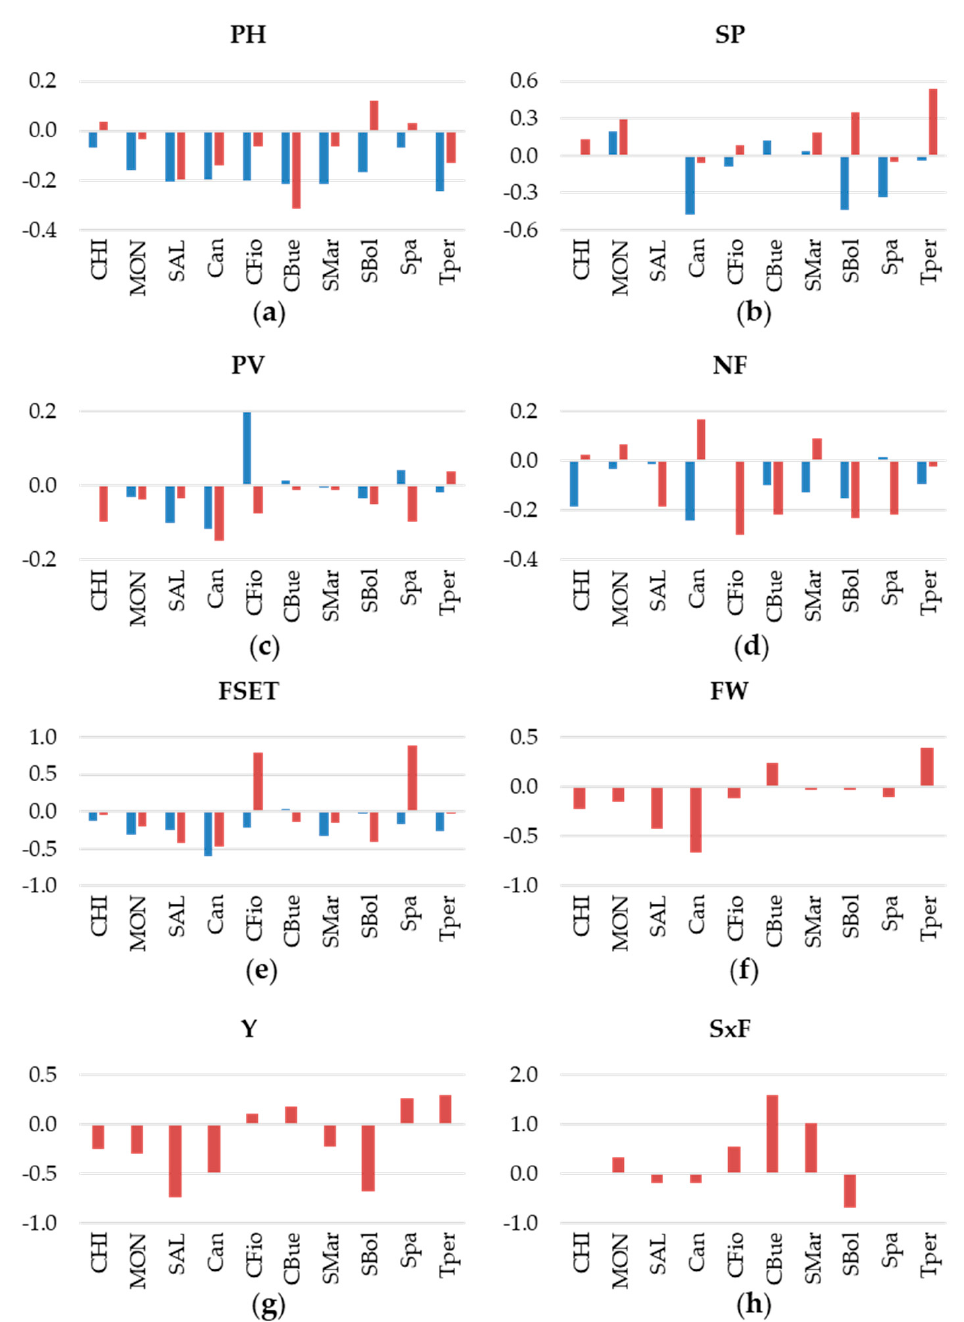
Figure 1. Relative variation in the heat versus the control field in 2007 (blue bars) and in 2019 (red bars) for the measured variables: ( a ) plant height (PH), ( b ) stigma position (SP), ( c ) pollen viability (PV), ( d ) number of flowers per inflorescence (NF), ( e ) fruit set (FSET), and, only in 2019, for ( f ) fruit weight (FW), ( g ) yield (Y), and ( h ) number of seeds per fruit (SxF). Variety names are abbreviated as follows: Chico III, CHI; Monalbo, MON; Saladette, SAL; Canestrino di Pisa, Can; Costoluto fiorentino, CFio; Cuor di bue, CBue; San Marzano, SMar; Scatolone di Bolsena, SBol; Spagnoletta, Spa; Tondo Perugia, Tper.